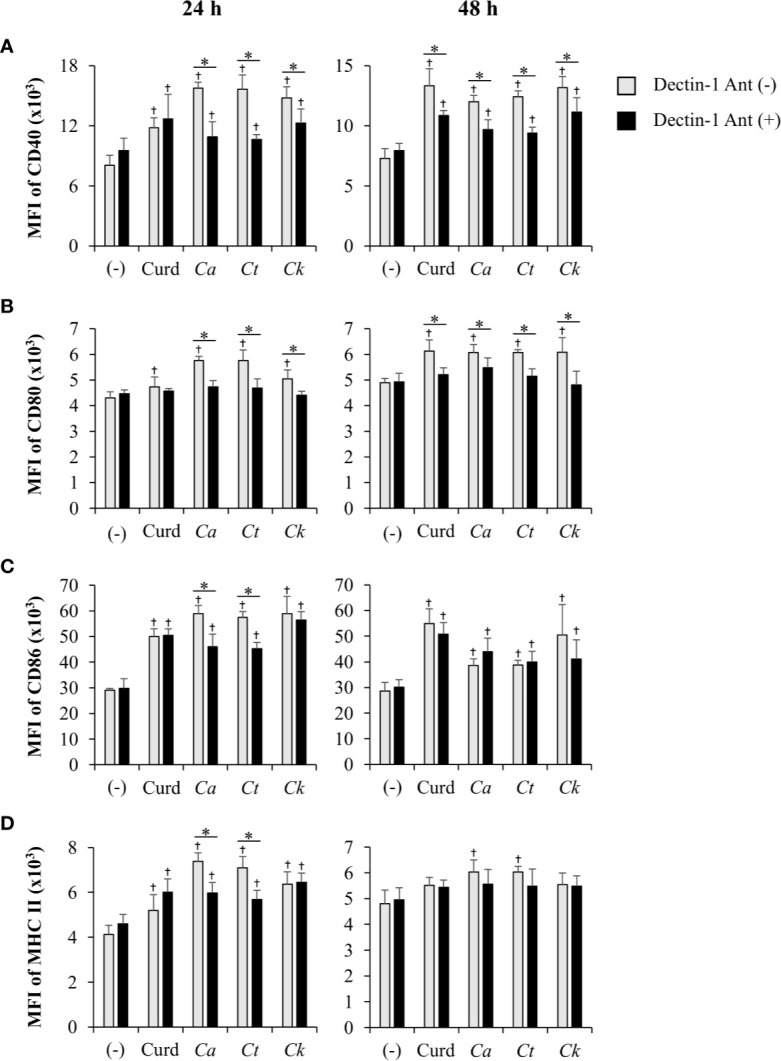
Inhibition of dendritic cell (DC) maturation by dectin-1 blockade. Bone-marrow derived DCs (BMDCs) were pre-treated with 25 µg/ml of dectin-1 antagonist for 2 h, and then the cells were stimulated with 25 µg/ml of curdlan and β-glucans isolated from C. albicans, C. tropicalis, and C. krusei for 24 h and 48 h. The geometric mean fluorescence intensity (MFI) of DC maturation markers (A) CD40, (B) CD80, (C) CD86, and (D) MHC class II on CD11c+ cells were determined using histogram analyses. n = 5; data are representative of two independent experiments. †
p < 0.05 compared with unstimulated BMDCs, *p < 0.05. (-), unstimulated BMDCs; Curd, curdlan; Ca, C. albicans; Ct, C. tropicalis; Ck, C. krusei.